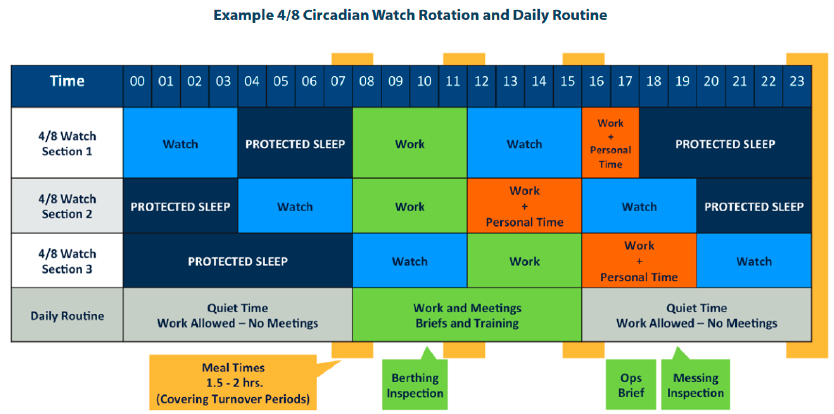
Figure 12. 4/8 Program Watch Rotation and Daily Routine [41]. Figure 12. 4 / 8 Program Watch Rotation and Daily Routine